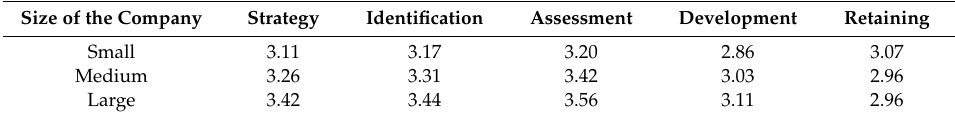
Table 4. Average score of talent management level in the phases of talent